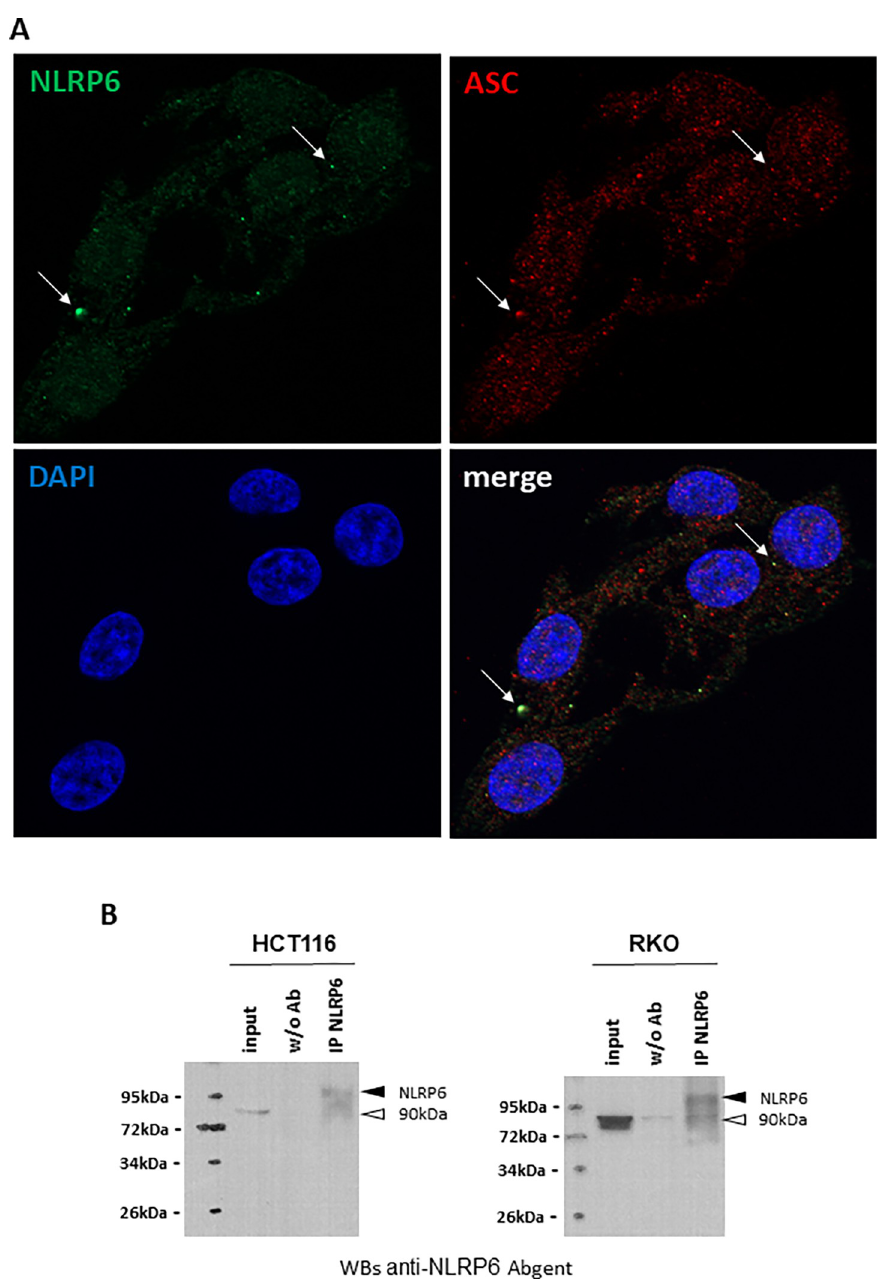
Fig 3. The endogenous NLRP6 protein is present only in cytoplasmic dots also containing the ASC protein. (A) Immunofluorescence microscopy images of HCT116 cells showing the colocalization of NLRP6 and ASC in small cytoplasmic dots (white arrows). (B) Immunoprecipitation of NLRP6 in HCT116 and RKO cell extracts followed by an analysis with anti-NLRP6 antibody from ABGENT. NLRP6 is indicated with a dark arrowhead. The white arrowhead points a non-specific doublet at